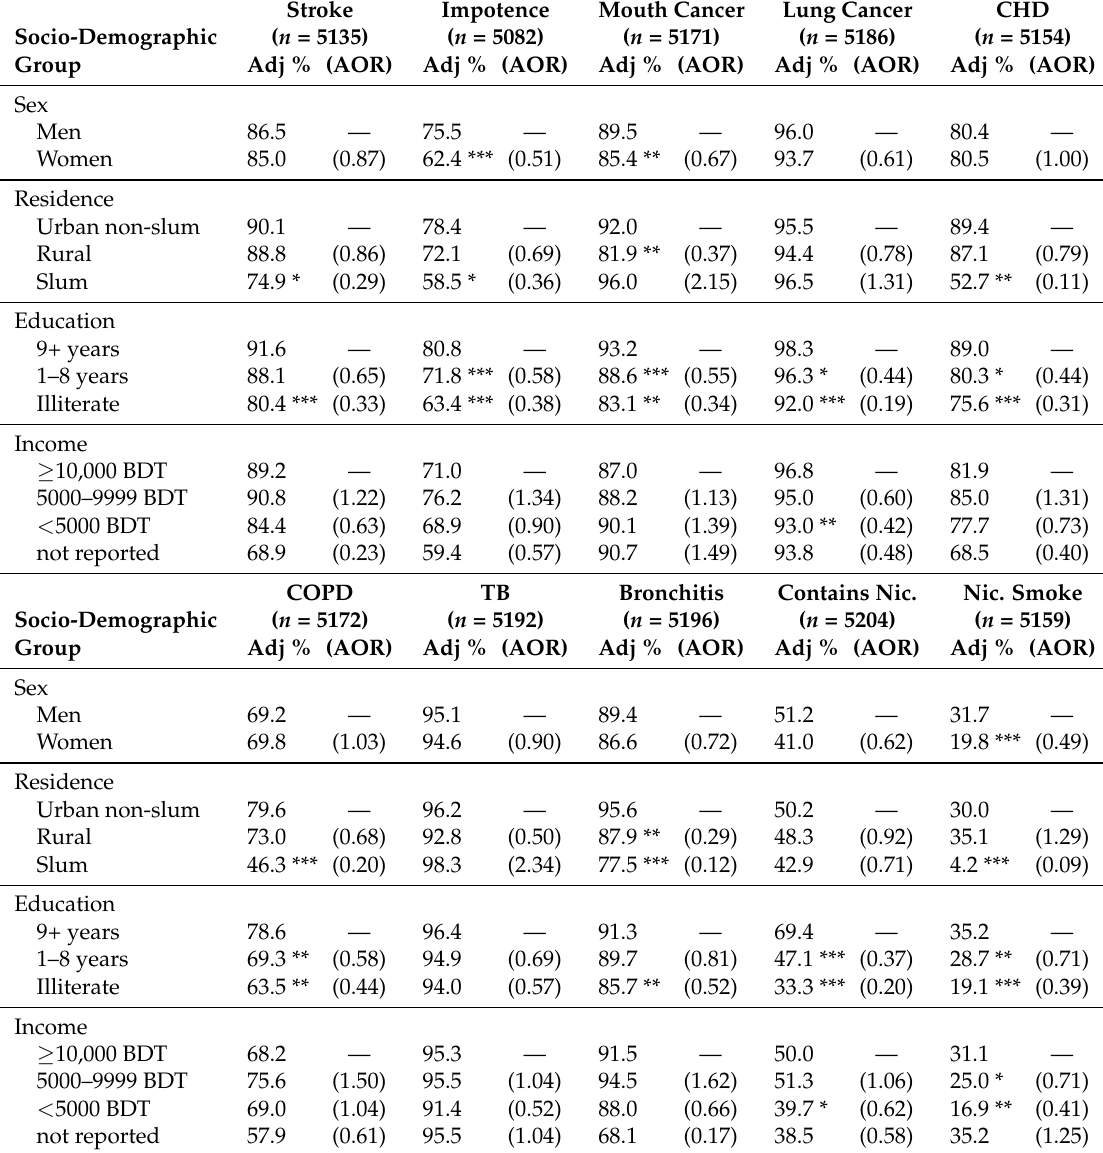
Table 3. Relationship between socio-demographic proxies of vulnerability and knowledge of the harms of cigarette smoking estimated using logistic regression †